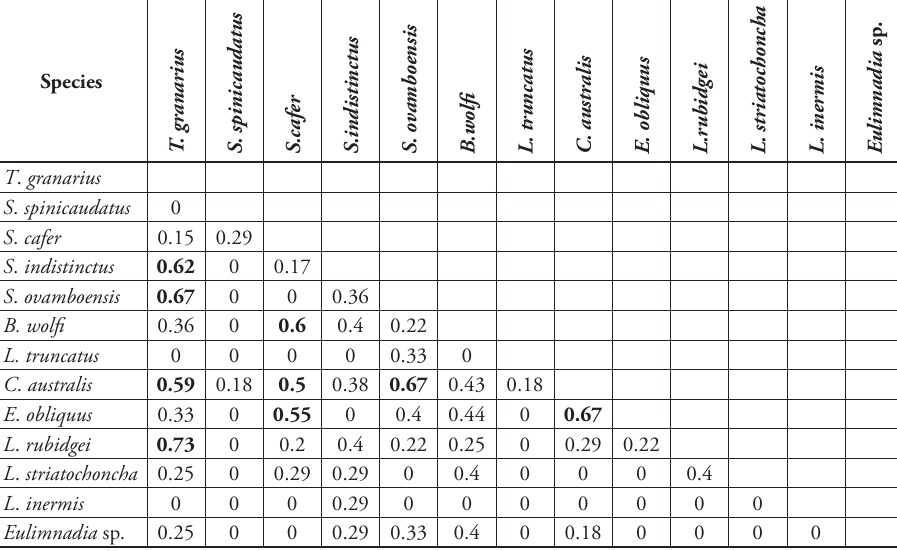
Bold values indicate high species